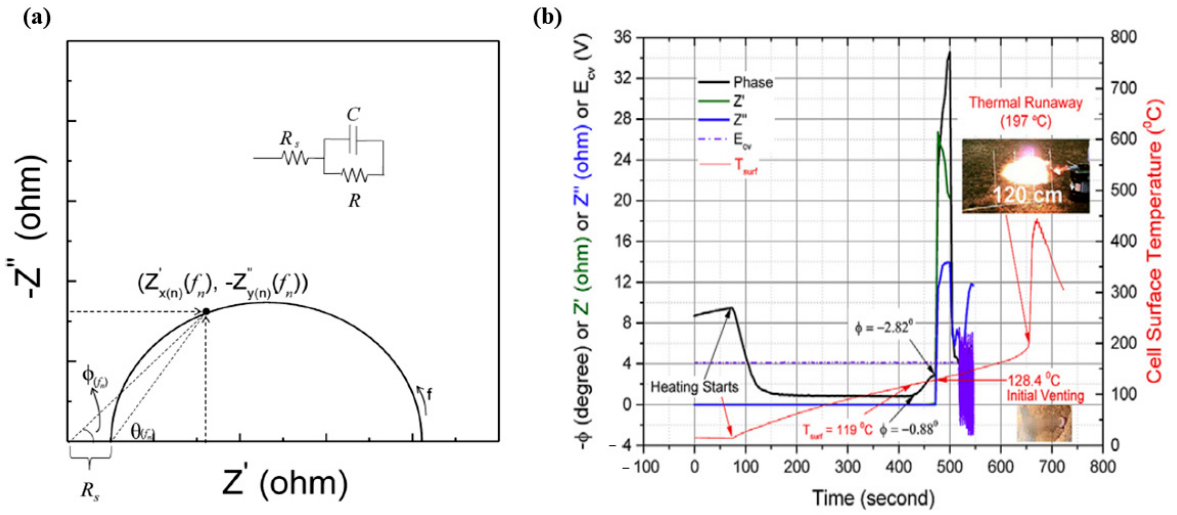
Figure 6. Through electrochemical impedance spectroscopy to detect TR: ( a ) Nyquist representation of the electrical impedance [90]; ( b ) Phase shift change before ba tt ery TR [93].